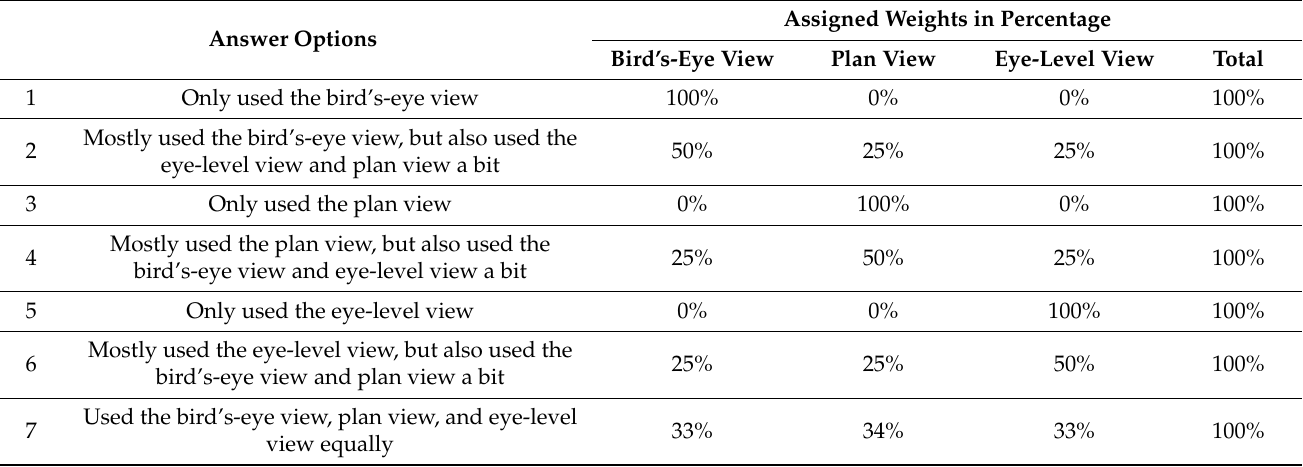
Table 1. Assigned percentage weightings for responses to Question 2 of the